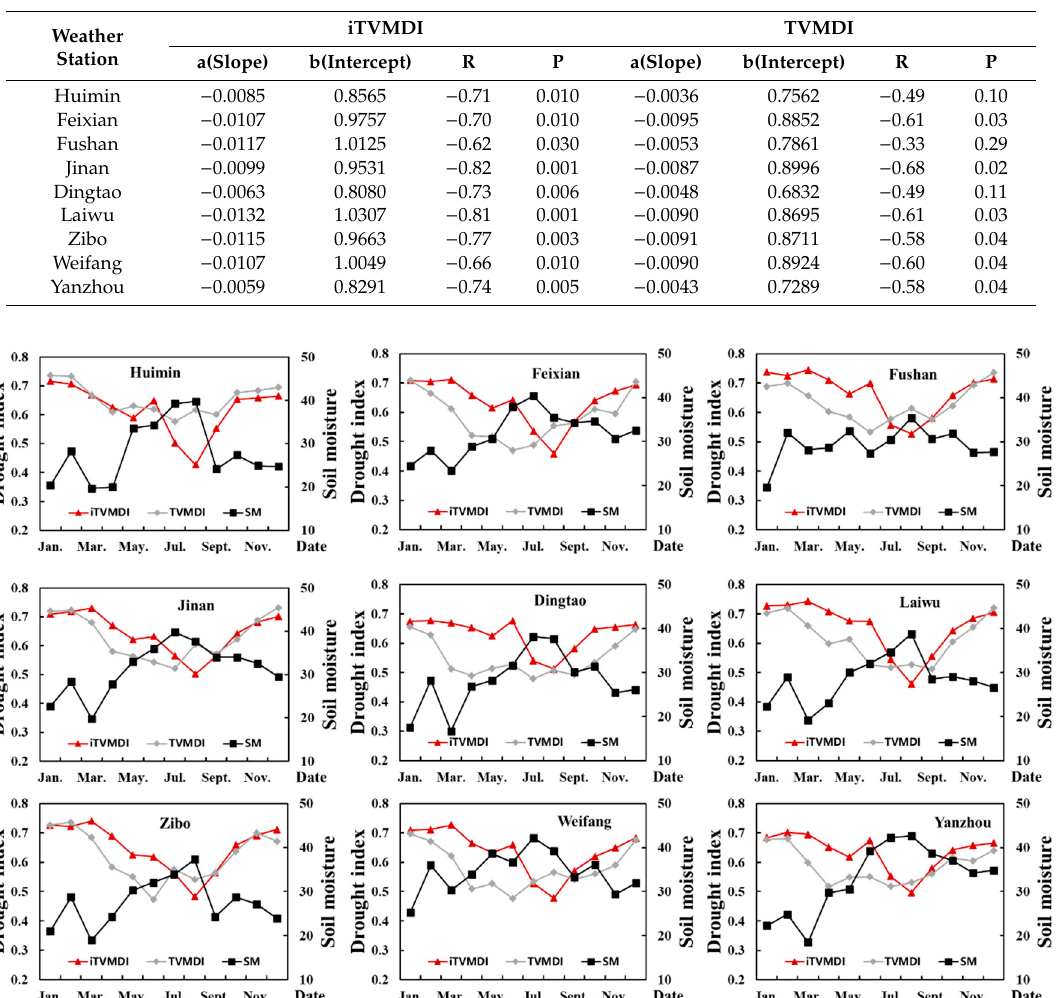
Table 1. The relationship between drought indices of nine stations and global land data assimilation system soil moisture (GLDAS SM).